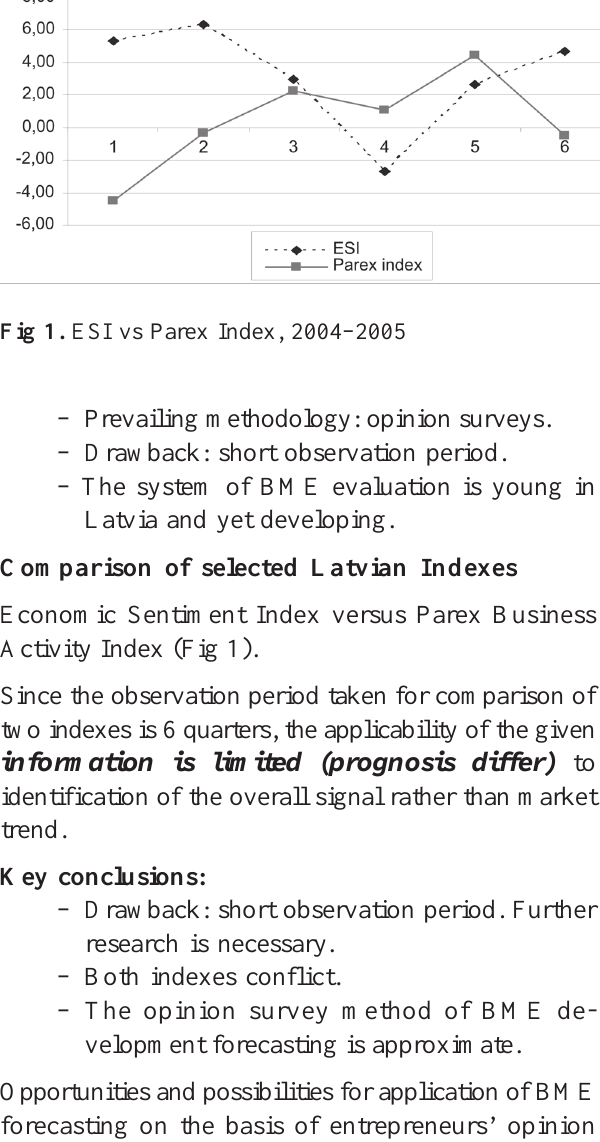
Fig 2. Ifo vs Rate of unemployed, 2002–2005